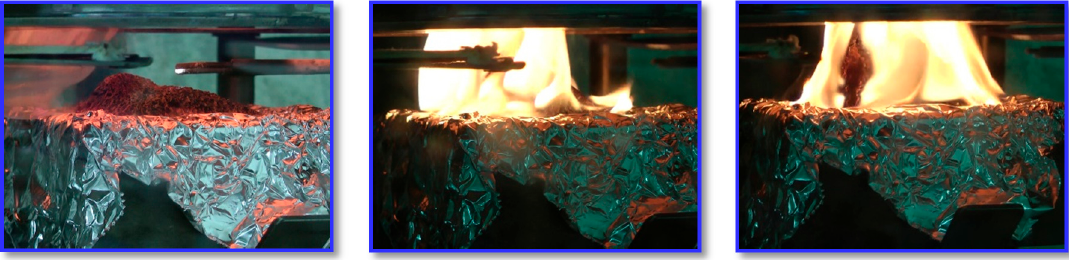
Figure 12. Photographs of PEEK when subjected to 60 kW/m² under the MLC at different times. ( left ) 79 s; ( middle ) 150 s; ( right ) 252 s.